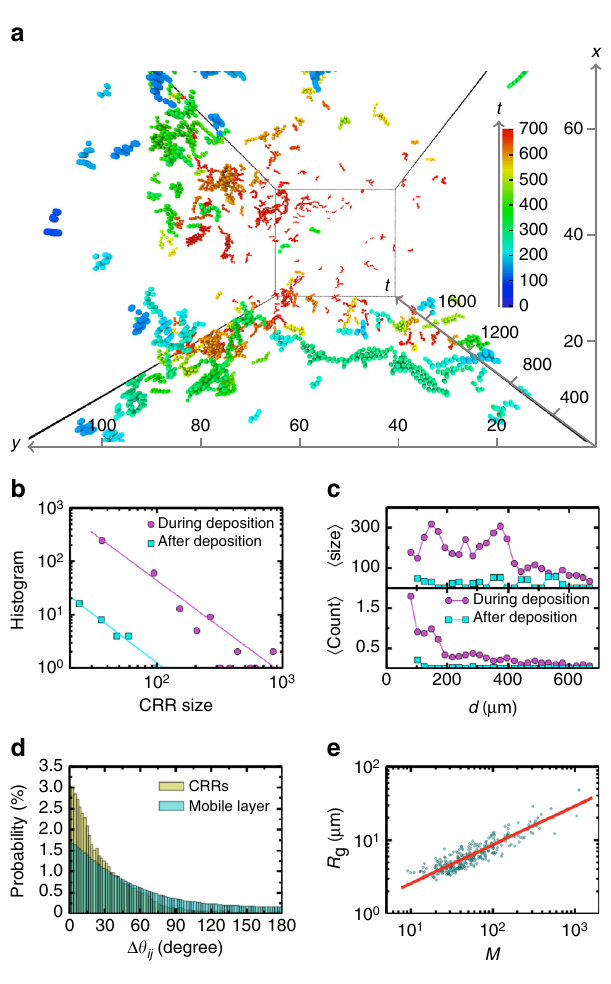
Fig. 3 CRR morphologies. a CRRs in spacetime at d > 72 μ m for a period of Δ t = 34,128 s during deposition. Colors indicate time. The unit for space is σ ¼ 5 : 25 μ m and the unit for time is τ = 18.1 s. b Histograms showing the 0 size of CRRs, i.e., the particle number in spacetime, fi tted by power laws with exponents γ = 1.74 ± 0.09 and γ = 1.79 ± 0.14 during and after deposition respectively. c The average CRR size and CRR count are much higher at 72 μ m < d ≲ 500 μ m than in the deeper bulk, indicating that a middle layer existed during deposition but vanished afterwards. d Histograms showing the angle Δ θ ij between the displacements of particle i and its neighbor j during 156 s in all the CRRs during deposition and in the (cid:3) P ! (cid:2) r ! surface mobile layer. e Radius of gyration R g ¼ m i r i c i P ! ! ¼ Σ = M is the position of the CRR ’ s center of M ¼ m i , where r c i m i r i i mass in spacetime, m i is the normalized area (i.e., m i = 1 for small particles) of particle i and Σ i is the sum over all particles in spacetime. The red line is the power-law fi tting R g / M 1 = d c with the fractal dimension d c = 1.91 ±